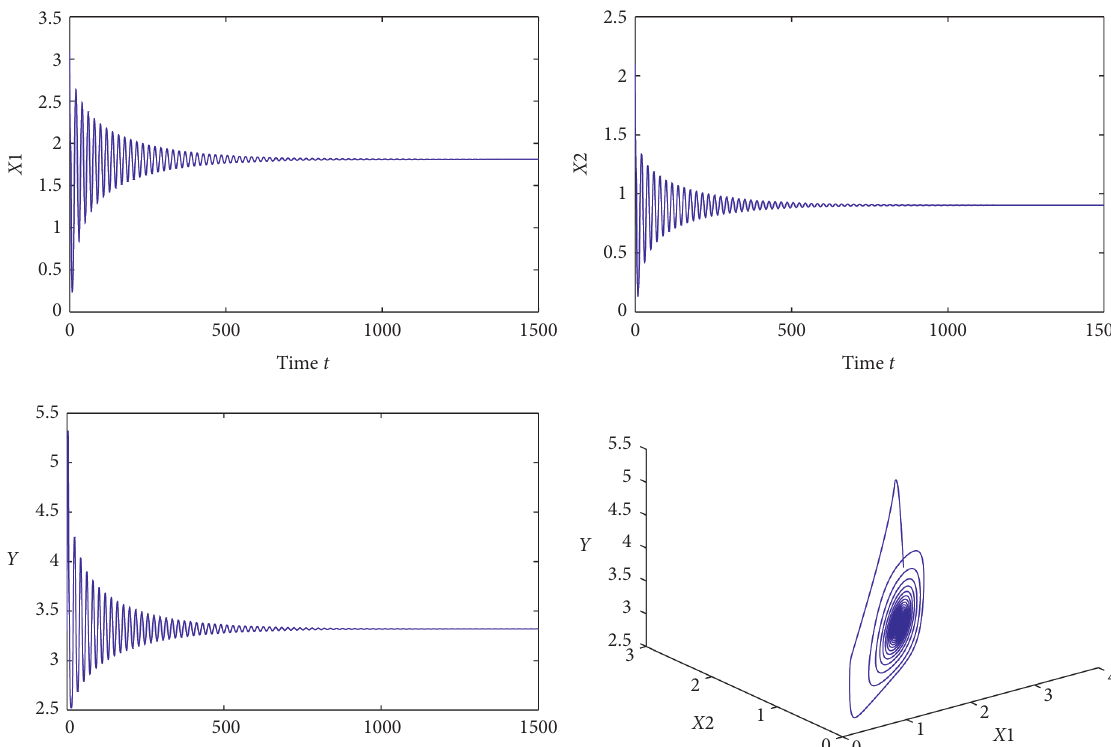
Figure 2: τ � 4 . 05 < τ . The positive equilibrium of system (3) is asymptotically stable. 0